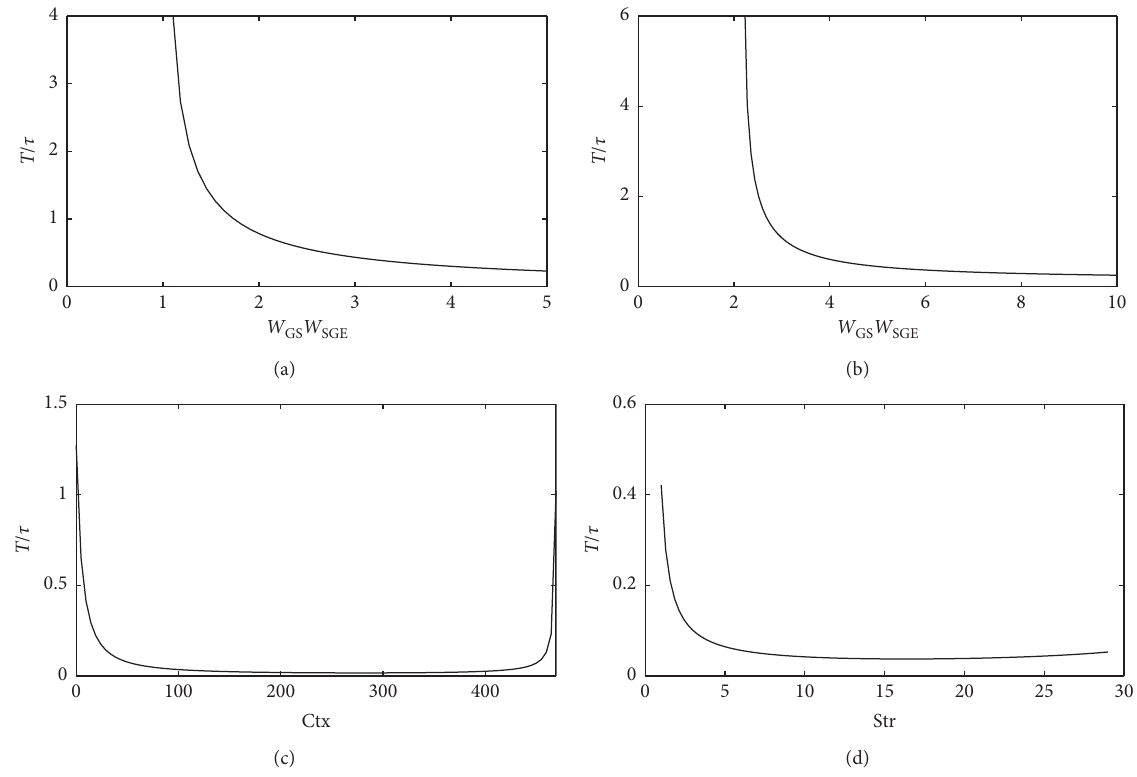
Figure 4: (a) Stability boundary curve for the linear system; (b) stability boundary for the nonlinear system; (c) the effect of cortical input on oscillation; (d) the effect of the striatum input on the oscillation. Ctx and Str denote the inputs from the cortex and